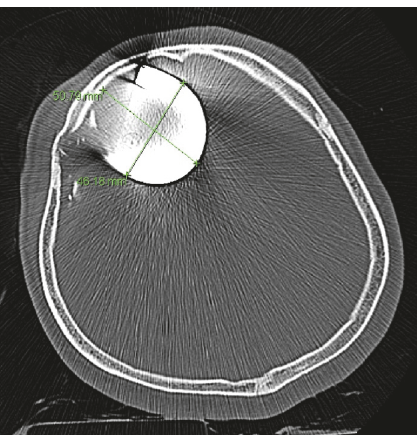
Figure 3: Axial computed tomography of the head (bone window), showing the intracranial penetration of a hook-shaped metal bar measuring 50.8 mm × 46.2 mm.